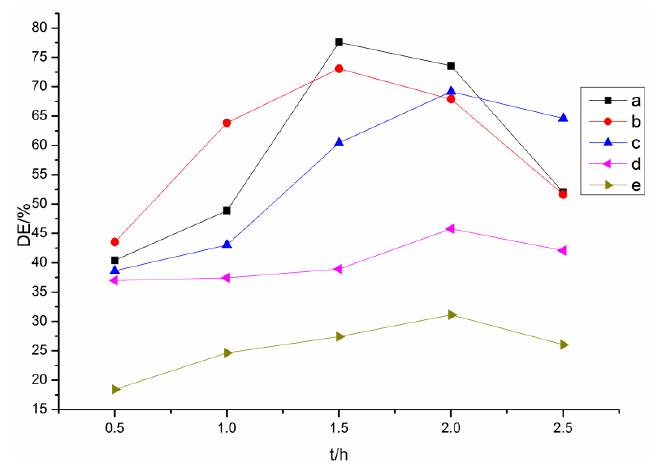
Figure 2. Degrees of esterification (Des) of lignin esters with different reaction times: ( a ) acetylated lignin; ( b ) propionylated lignin; ( c ) butyrated lignin; ( d ) succinylated lignin; ( e ) maleylated lignin.